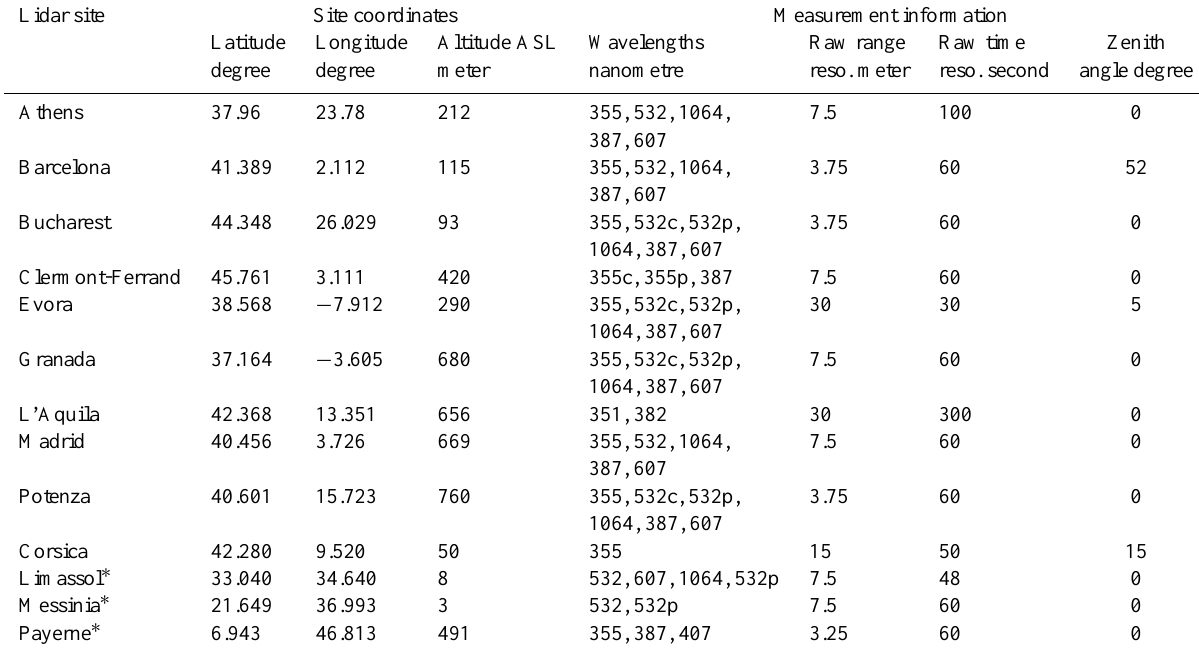
Table 1. Description of the lidar systems used in this study. “Reso.” stands for resolution. “ASL” stands for a.s.l. (altitude above sea level). The letters “p” and “c” in the wavelengths stand for parallel and cross linear polarisation component respectively.